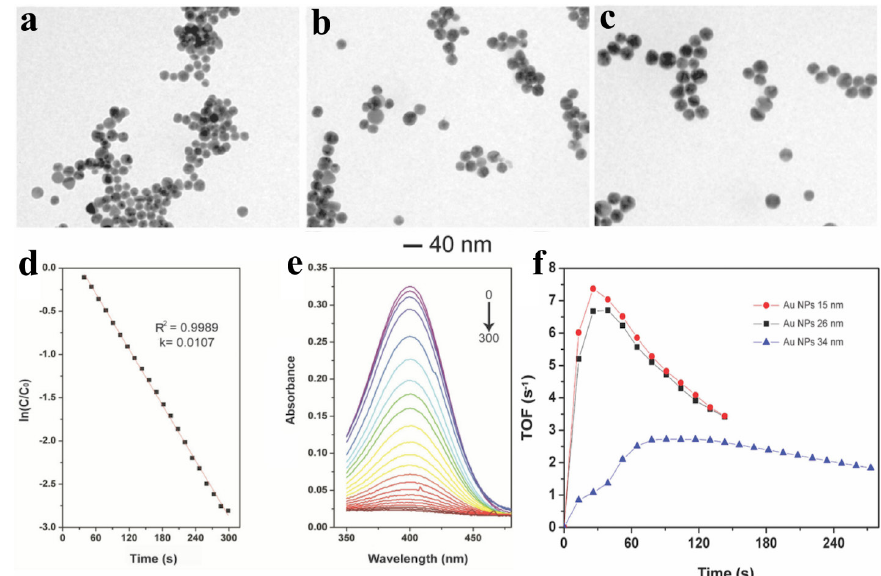
Figure 12 - TEM images of Au nanospheres with a) 15, b) 26 and c) 34 nm, respectively. d) Plot of ln(C/C ) and e) UV-Vis spectra recorded as a function of time at room temperature for Au 0 nanospheres with 34 nm in diameter. f) Calculated TOFs as a function of time for the 15, 26 and 34 nm Au nanospheres (red, black and blue traces, respectively). Adapted with permission from ref. (da Silva et al. 2014) Copyright 2014 Scielo Brazil.